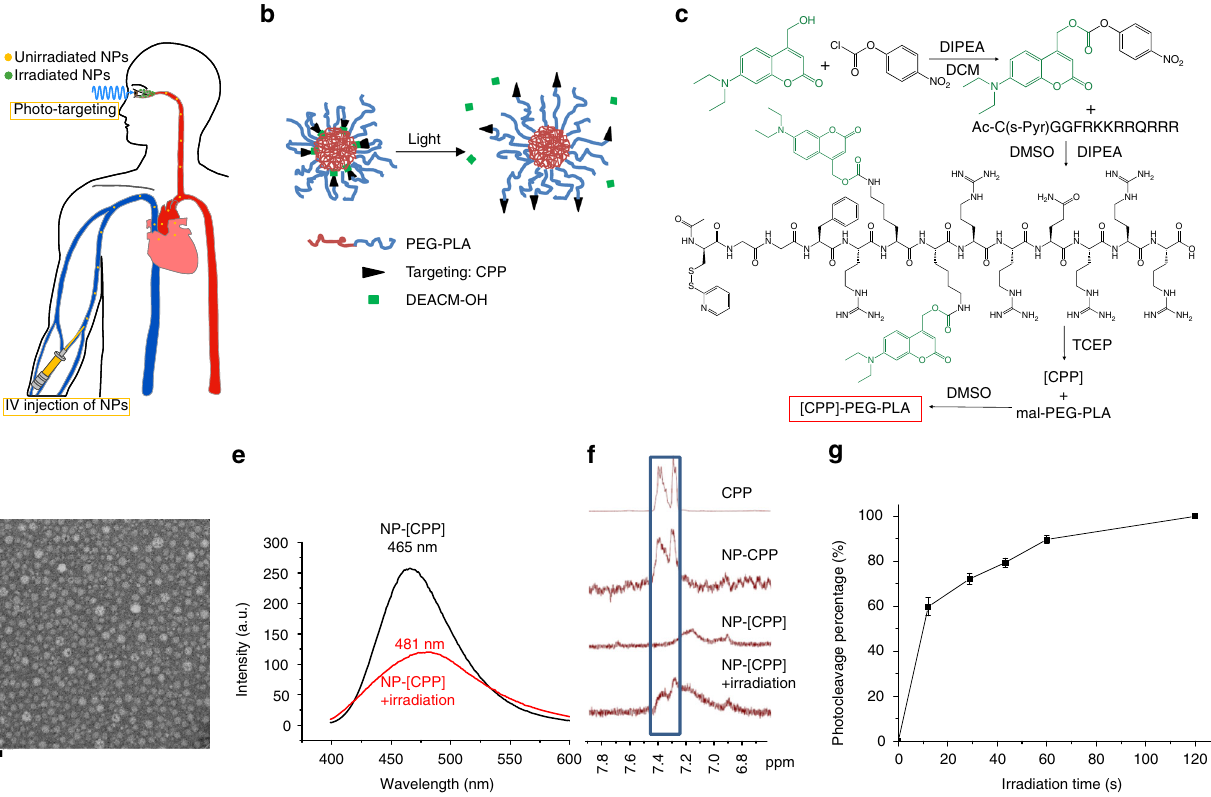
Fig. 1 Preparation and characterization of phototargeted nanoparticles. a Phototargeting intravenously administered nanoparticles to choroidal neovascularization. b Schematic of light-triggered activation of the nanoparticle. c Synthesis of the polymer chain functionalized with caged CPP ([CPP]). d Transmission electron microscopy (TEM) image of NP-[CPP]. The scale bar is 50 nm. e Fluorescence emission spectra of NP-[CPP] and NP-[CPP] irradiated for 1 min (50 mW cm − 2 , 400 nm) in PBS, the emission maxima are labelled. f 1 H NMR spectra of free CPP and different nanoparticles in D 2 O, with the signature phenylalanine proton peaks highlighted in the blue rectangle. NP-CPP is the nanoparticle formed from CPP-PEG-PLA and mPEG-PLA (1:4 weight ratio). Irradiation was with a 400 nm LED for 1 min at 50 mW cm − 2 . g Photocleavage of NP-[CPP] in PBS (0.5 mg mL − 1 ), as determined by HPLC (detected at 390 nm absorbance), after continuous irradiation (50 mW cm − 2 , 400 nm) (data are means ± SD; n = 4 independent